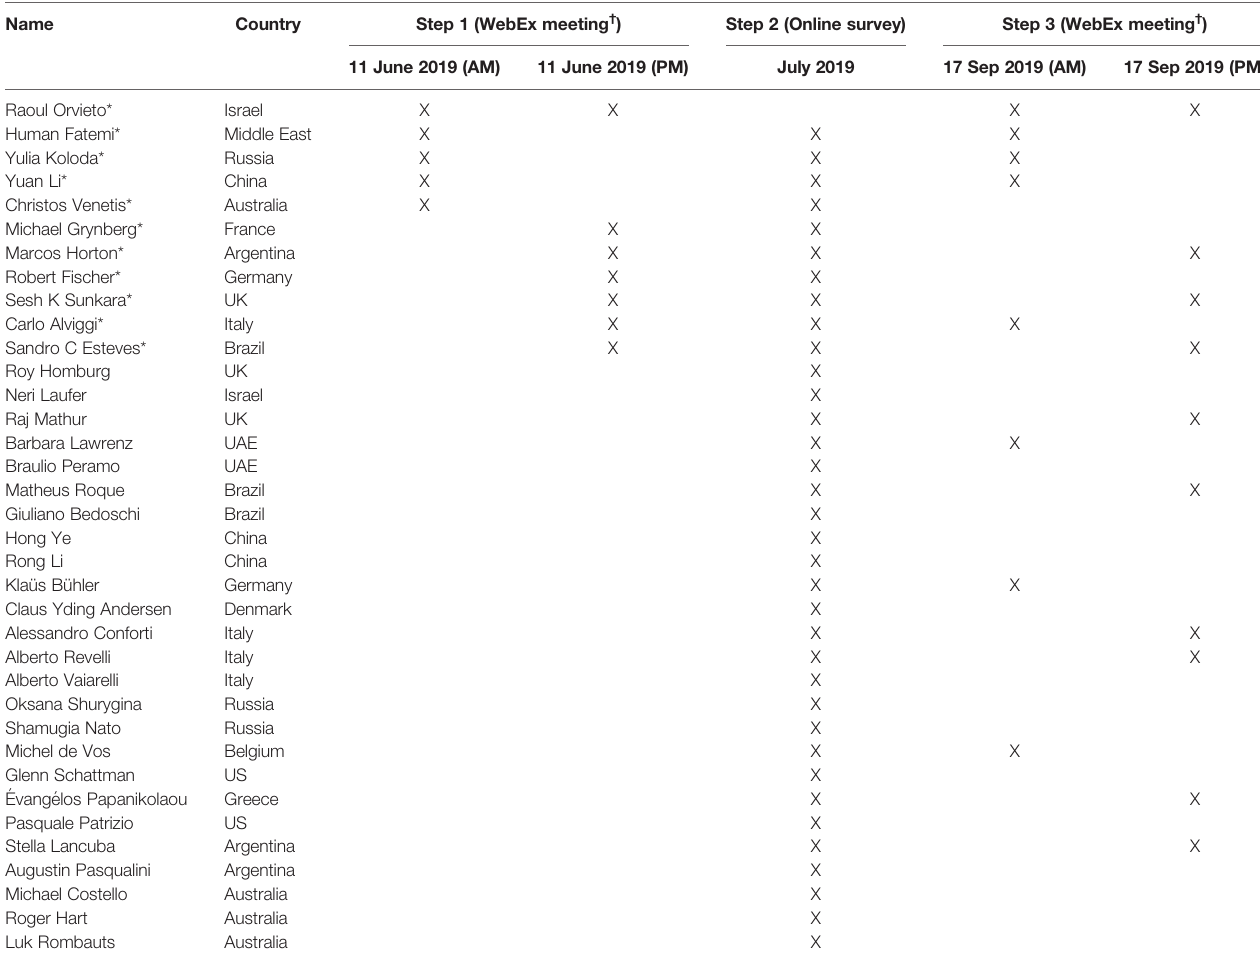
TABLE 1 | Participants involved in Step 1, Step 2 and Step 3 of the